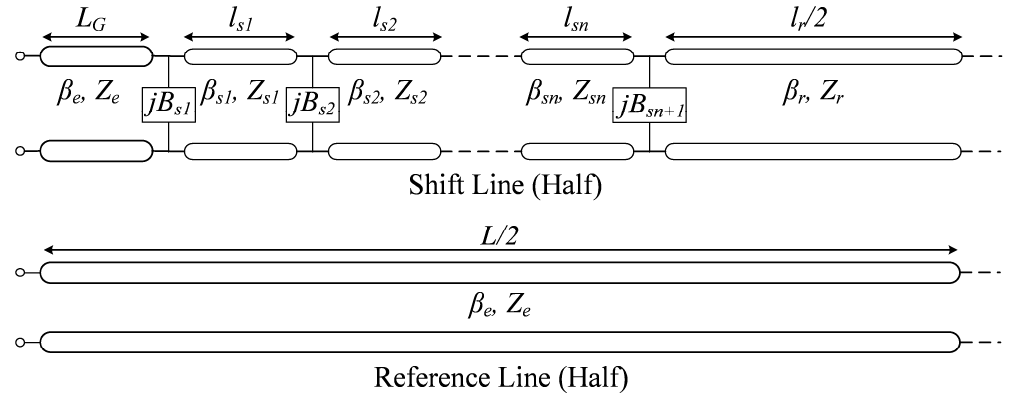
Figure 3. Mono-mode electrical equivalent circuit for one half DPS.